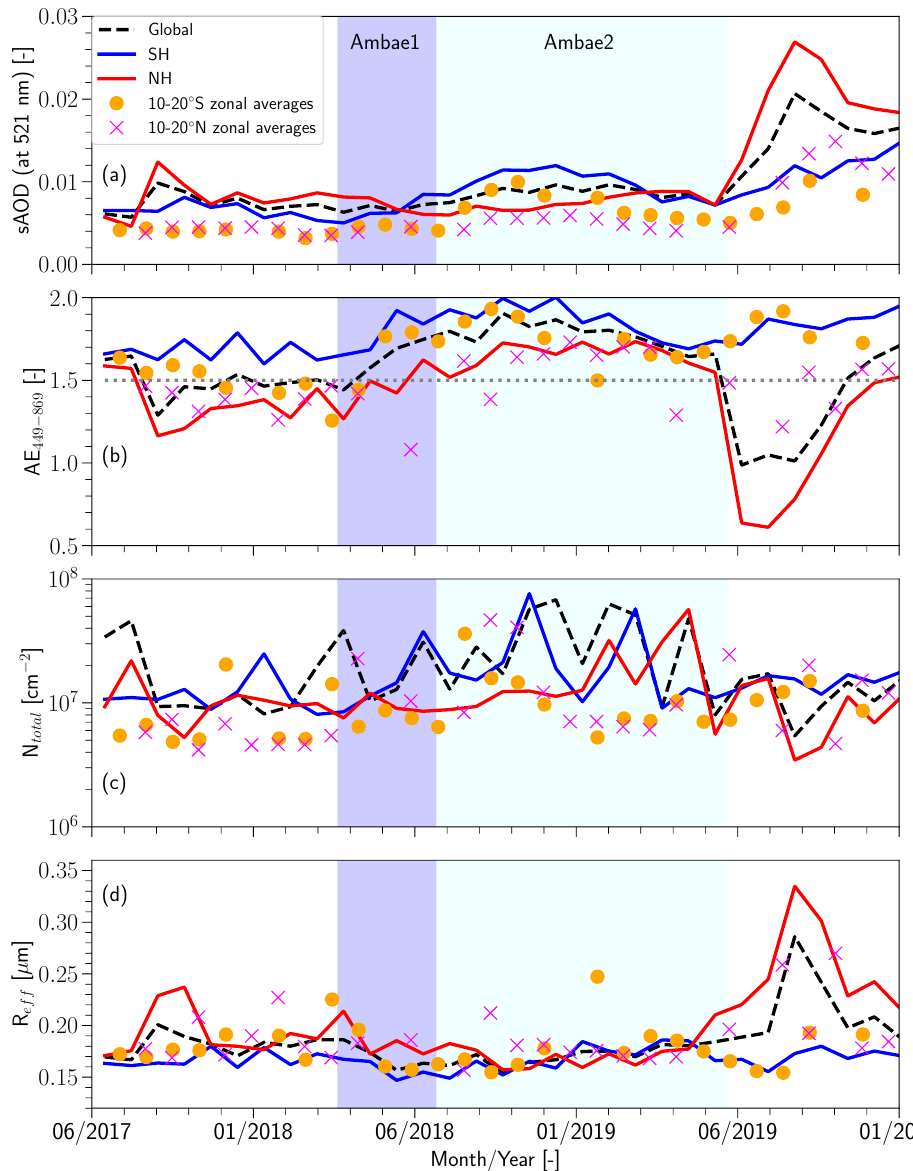
Figure 3. Temporal variation of area-averaged ( a ) sAOD (at 521 nm), ( b ) AE 449 869 , ( c ) total number −− concentration, and ( d ) effective radius (R ef f ) over global, SH, and NH regions (including the zonal averages along the two latitude bands, namely, 10–20 ◦ S and 10–20 ◦ N. Black dotted horizontal line in ( b ) corresponds to AE 449 869 = 1.5. The light blue and azure background shaded portions − correspond to the Ambae1 and Ambae2 periods, respectively. Note that sAOD and AE 449 869 values − are independent of our inversion